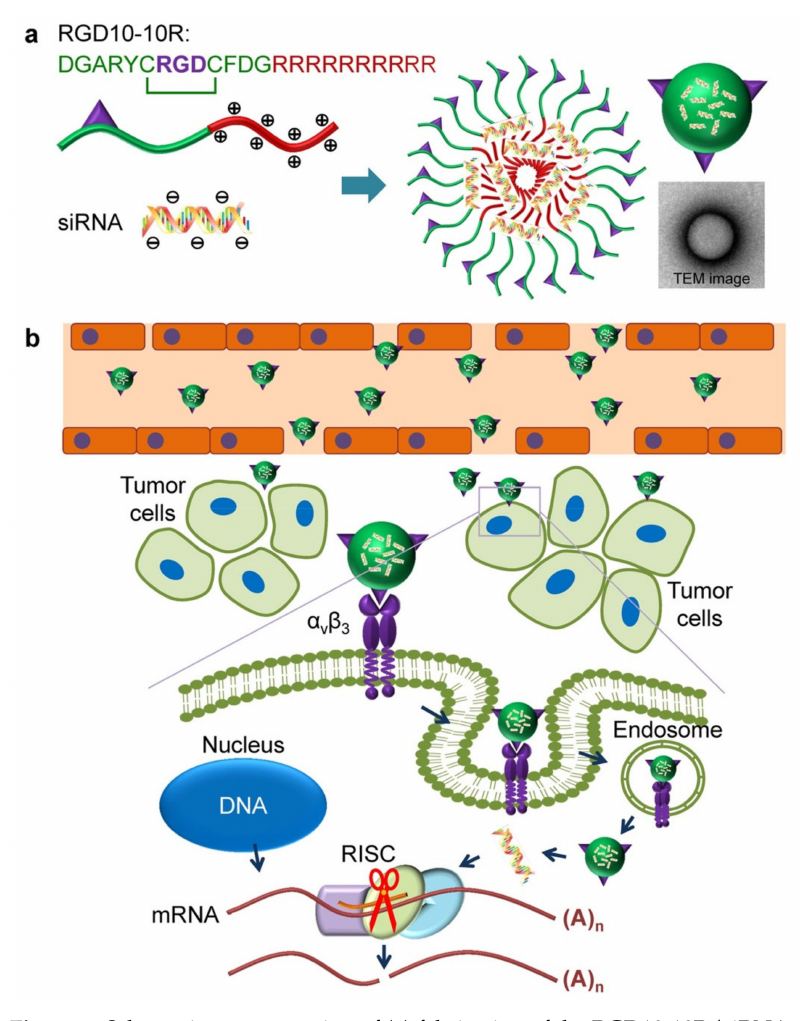
Figure 2. Schematic representation of ( a ) fabrication of the RGD10-10R/siRNA complex, ( b ) tumor- targeted siRNA delivery involving ligand/receptor interactions. siRNAs accumulated in the tumor tissue and then entered the tumor cells in a receptor ( α v β 3)-mediated endocytosis (RME) man- ner in vitro. After being internalized by cells, peptide/siRNA complexes escaped from the endo- somes/lysosomes. Then, siRNAs were released from the complexes and loaded by RNA-induced silencing complex (RISC). Targeted messenger RNA complementary to the guide strand (antisense strand) of siRNA was selected and cleaved by argonaute protein. Reprinted with permission from [31]. Copyright 2015 Springer